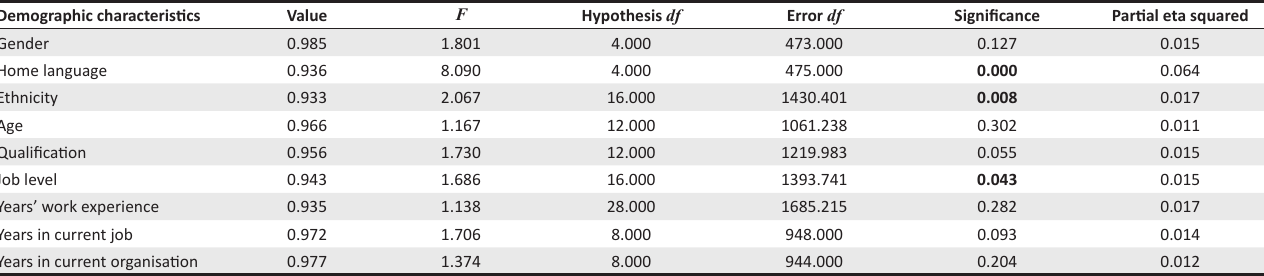
TABLE 4: Multivariate analysis of variance analyses – Professional behaviour and leadership and demographic groups. Demographic characteristics